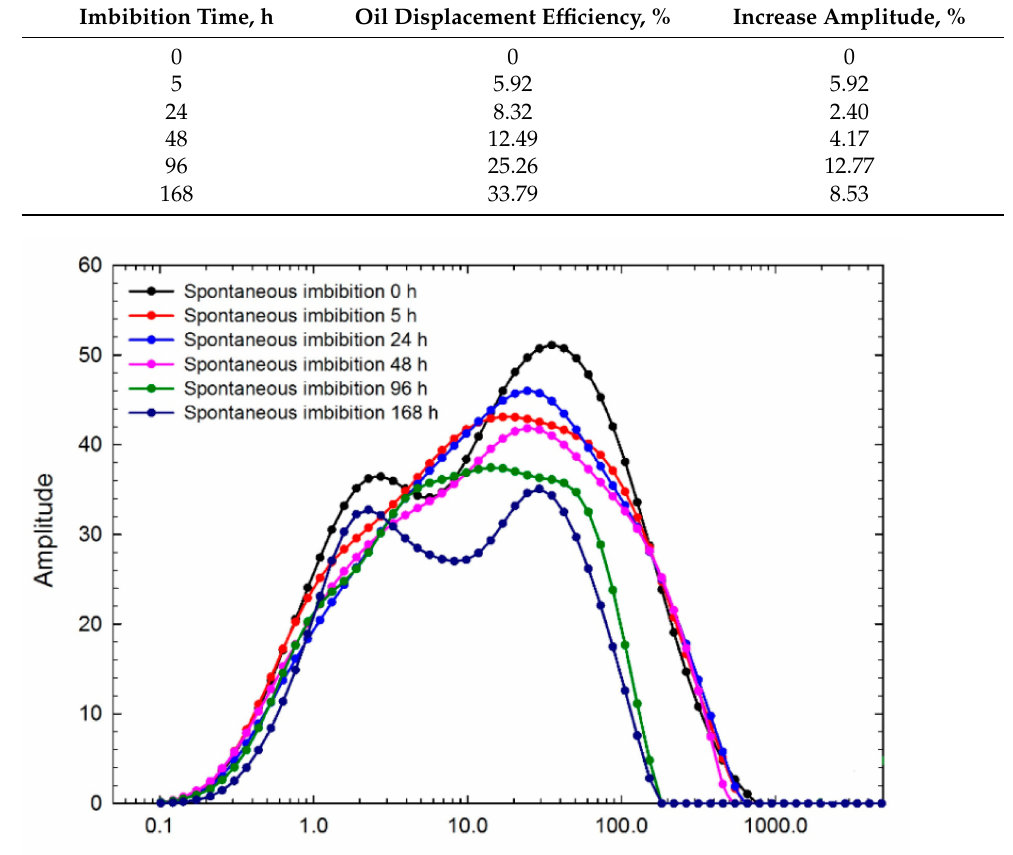
Figure 11. NMR online tests system. Table 1. Oil displacement efficiency of spontaneous imbibition at different times.